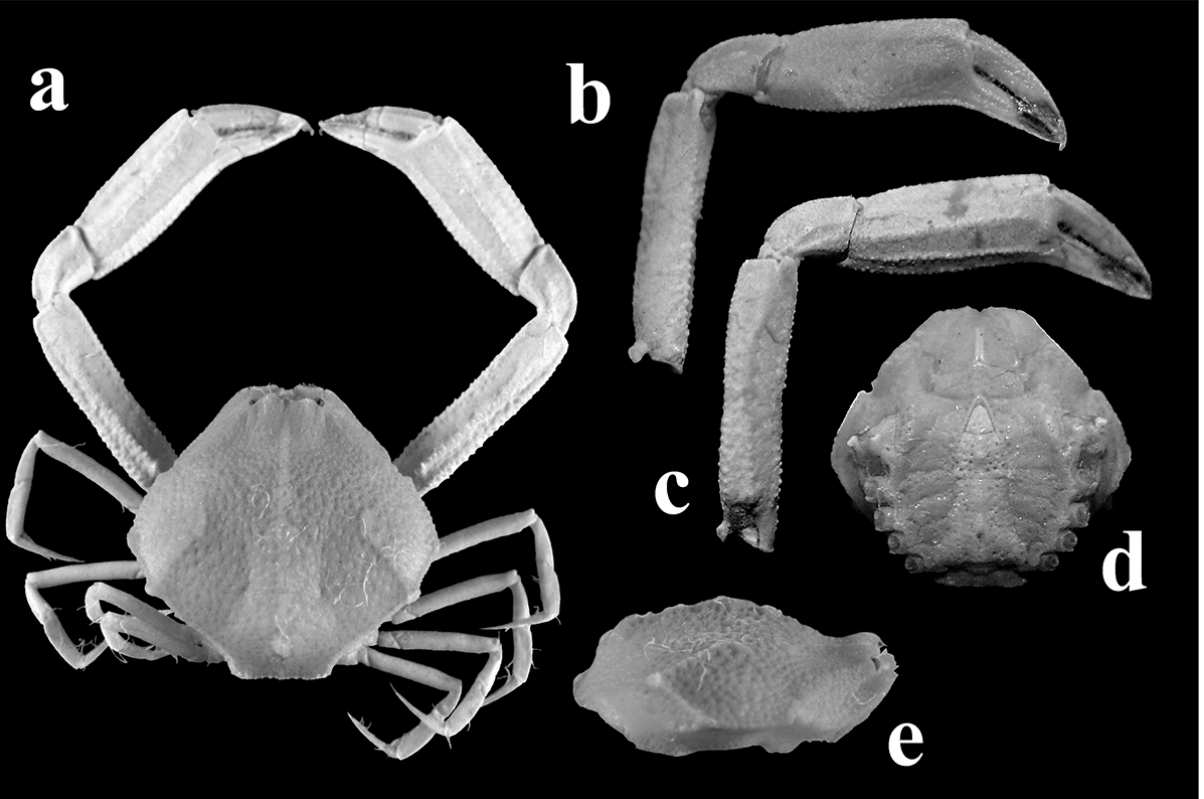
Figure 2. Bellayra sexangula gen. nov., comb. nov., male (CL 7.3 mm, CB 8.15 mm) (LFSc. ZRC-149). a , Habitus, dorsal view; b , right cheliped, outer view; c , right cheliped, inner view; d , carapace, ventral view; e , carapace, lateral